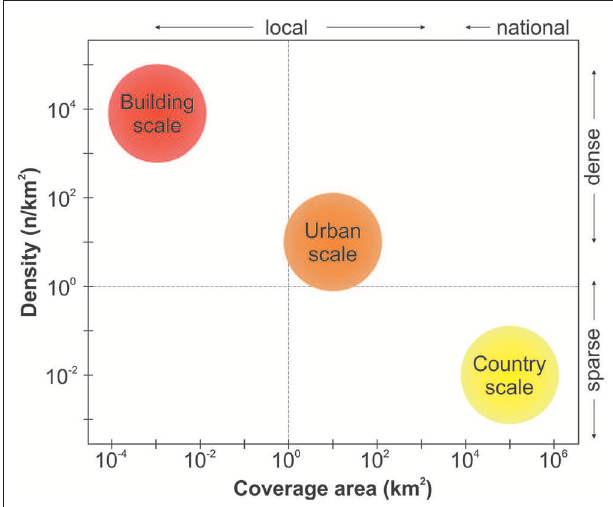
FIGURE 1 | Schematic representation of the country-scale, urban-scale, and building-scale monitoring networks in terms of coverage area and density of